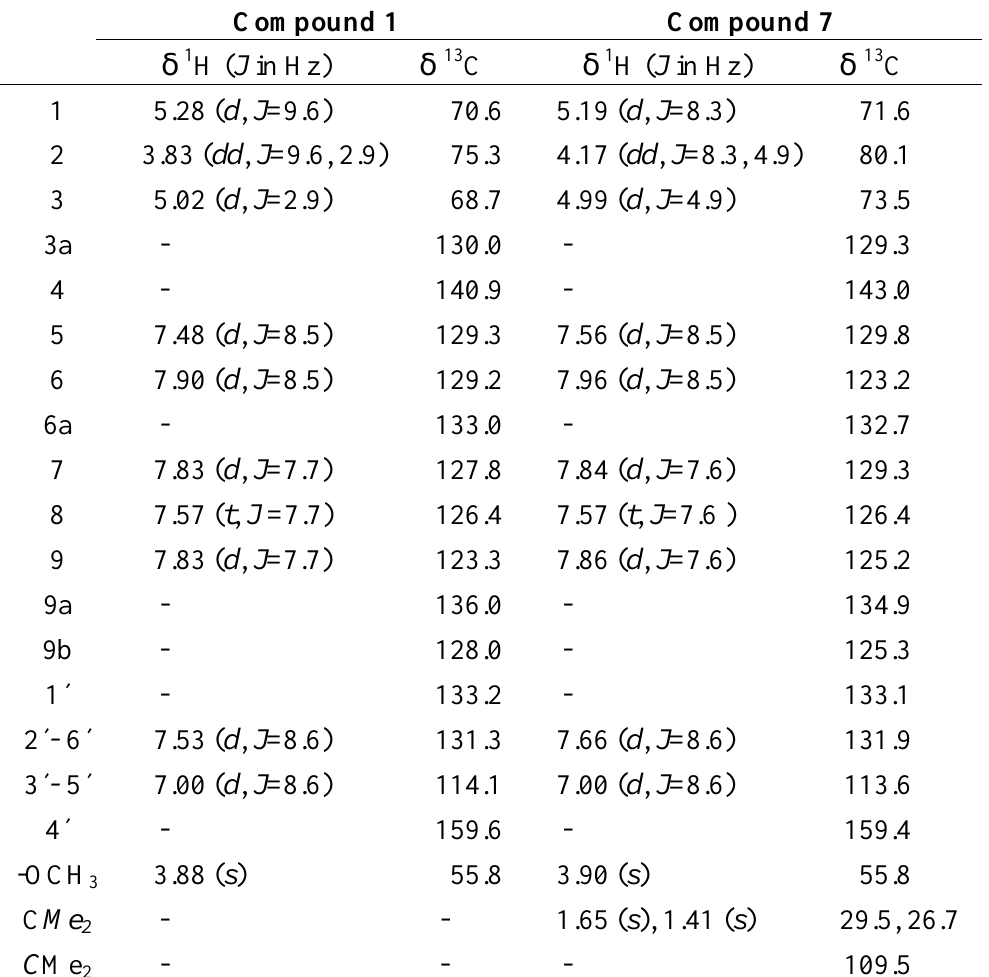
Table 2. 1 H and 13 C NMR data of compound 1 and acetonide derivative 7